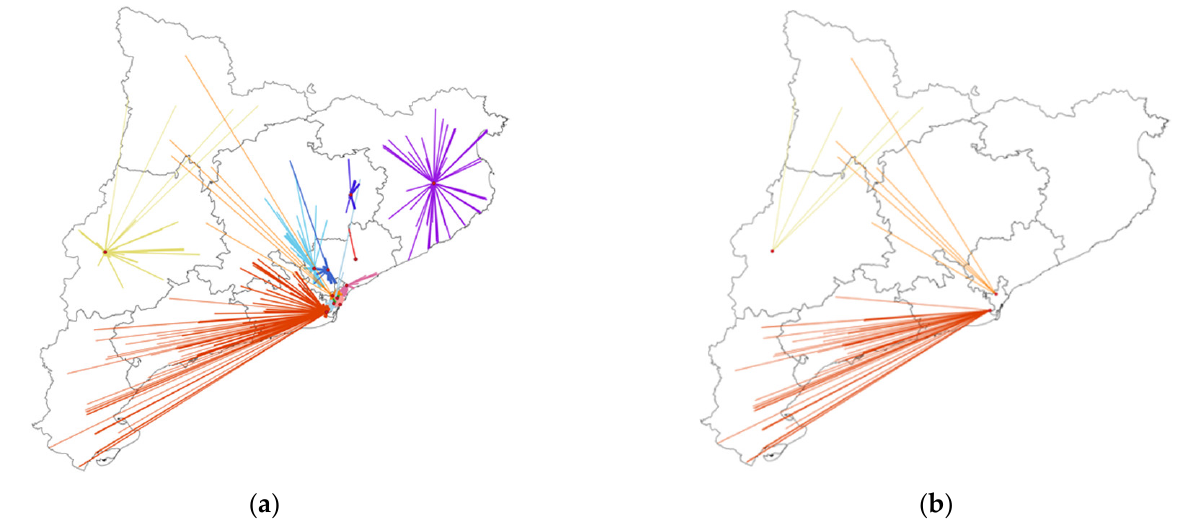
29.70 km. p - values below 0.05 (two-sided) were considered to indicate statistical significance. Chi- square test.* Statistically significant.